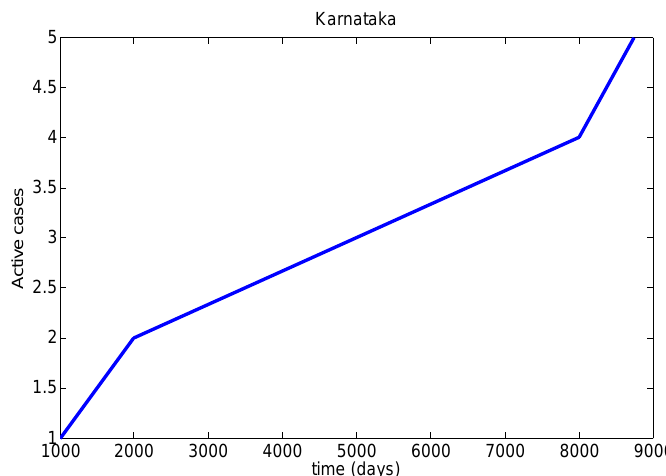
Figure 9. Active cases of Karnataka from real life data.